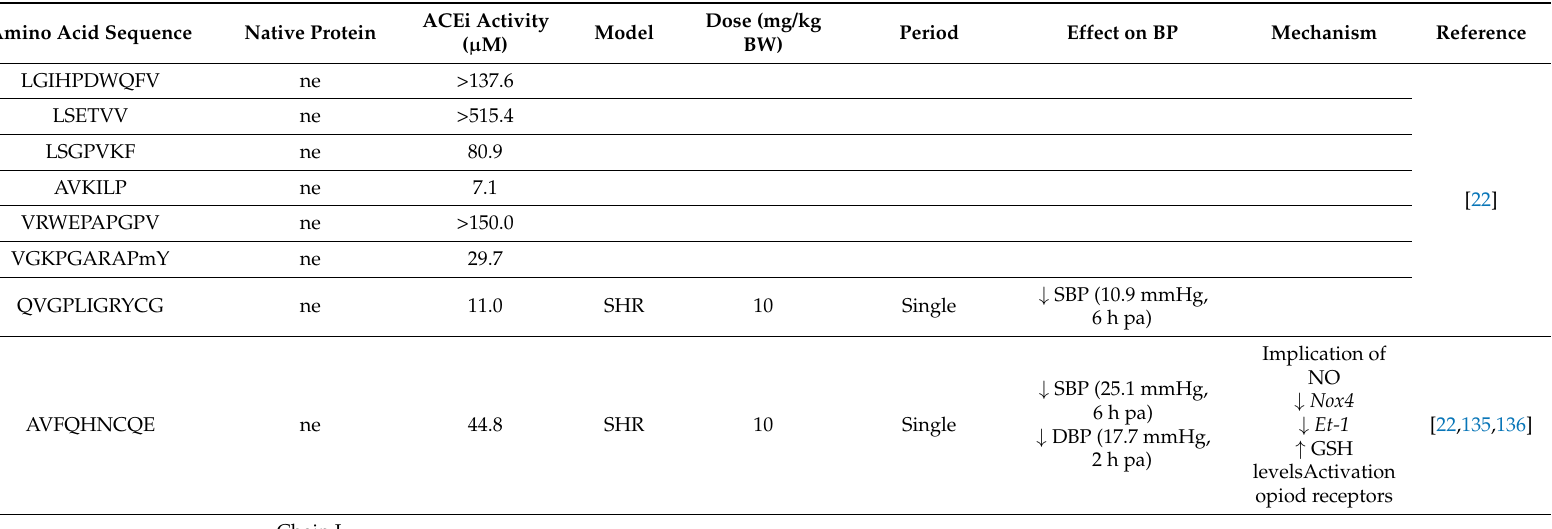
Table 3. Angiotensin-converting enzyme-inhibitory and antihypertensive activities shown by the peptides identified in hydrolysates obtained from chicken byproducts.